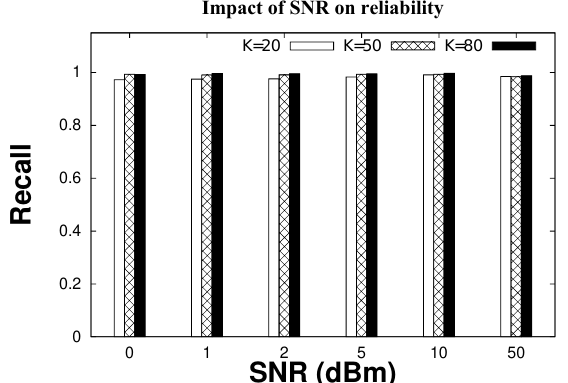
Figure 11. Recall for different antennas with varying